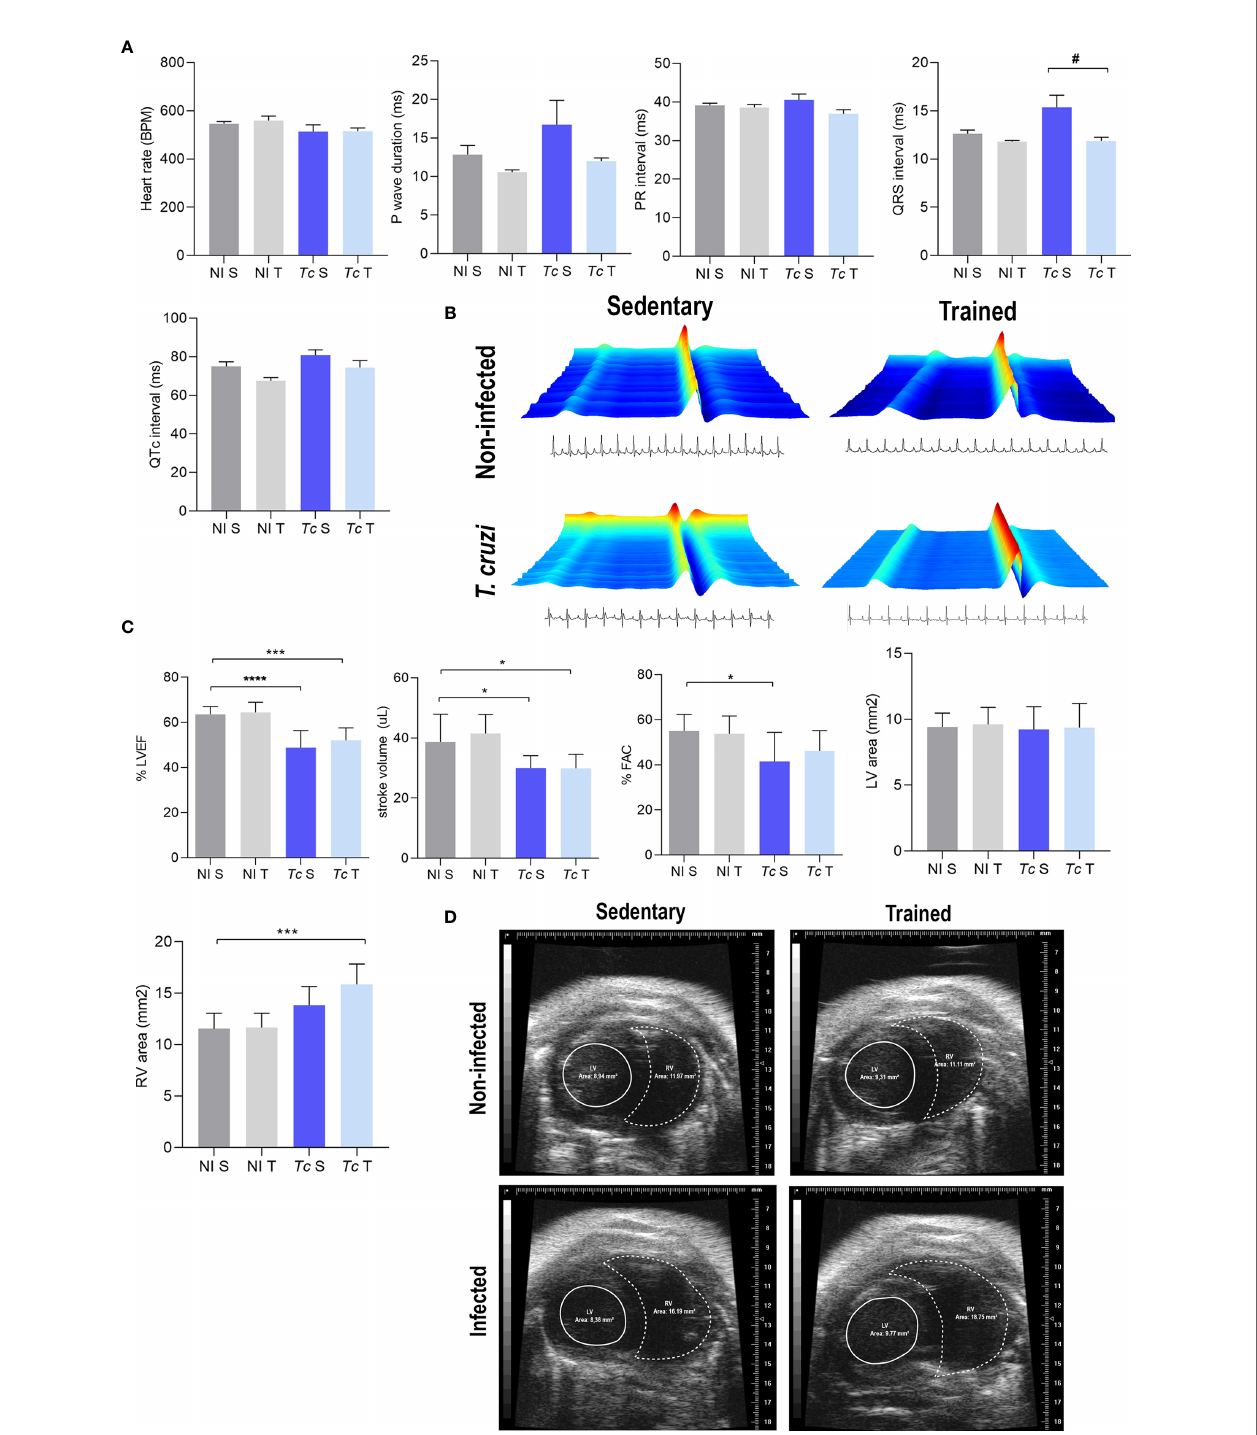
FIGURE 3 | T. cruzi infection does not induce electrical alterations but leads to ECHO abnormalities in C57BL/6 mice at 180 dpi. Absence of electrical alterations in C57BL/6-infected mice at 180 dpi. (A) ECG records show the average heart rate (beats per minute, bpm), P wave duration (ms), variation in PR and QTc intervals, and QRS complex (ms). (B) Representative ECG register segments. (C) ECHO records show the % left ventricular ejection fraction (LVEF), stroke volume (µL), % FAC, LV area (mm 2 ), and RV area (mm 2 ). (D) Representative ECHO images of ventricular areas. The data are represented as means ± SEM. Data represent eight to nine mice per group. Signi fi cant differences between the untrained and trained groups. # p < 0.05. Signi fi cant differences between infected and uninfected groups. *p < 0.05; ***p < 0.001; ****p < 0.0001 ( Kruskal – Wallis Dunn ’ s posttest